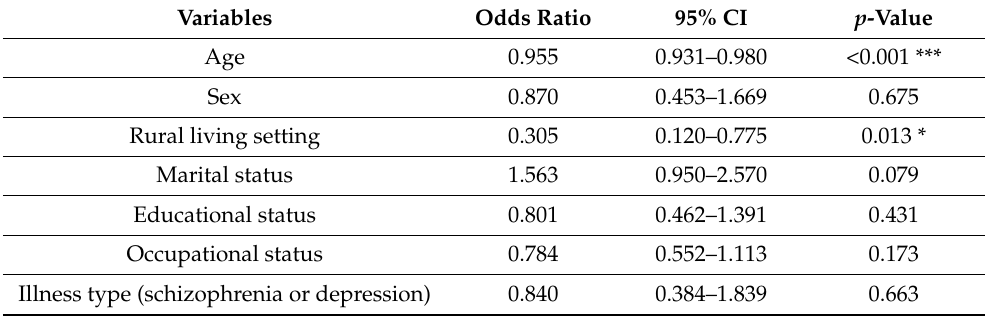
Table 7. Time spent online (use of internet 150 min or more per day)—multivariate regression analysis.